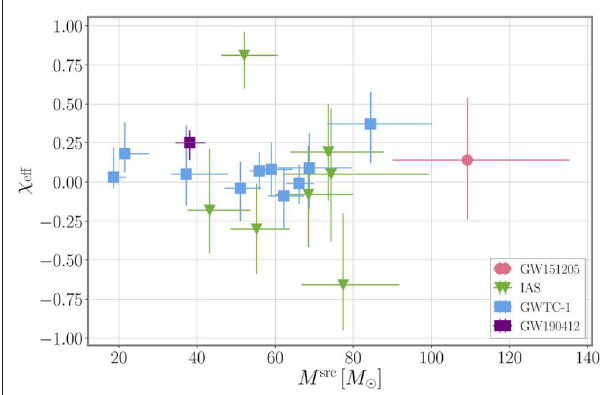
FIGURE 2 | Inferred total source-frame masses and effective inspiral spin of BBH observations. The error bars indicate the 90% credible interval of the 1D posterior probability. Blue square markers: Ten BBH events from GWTC-1 (Abbott et al., 2019c); purple square marker: GW190412 (Abbott et al., 2020 ); green triangular markers: events from Zackay et al. (2019) and Venumadhav et al. (2019a); red round marker: event GW151205 from Nitz et al. (2019a). Posterior samples were obtained from LIGO Scientific Collaboration, Virgo Collaboration (2018), Nitz et al. (2019b), Venumadhav et al. (2019c), and Abbott et al. (2020). The conversion from detector-frame to source-frame masses assumes a flat 3 CDM cosmology ( Ade et al.,